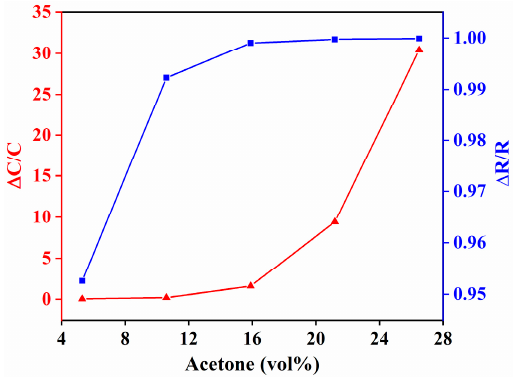
Figure 12. Comparison of changes in resistance vs. capacitance of ZIF-8 film coated onto IDE-substrate-based acetone sensors. The capacitance and resistance values were measured at 100 kHz.